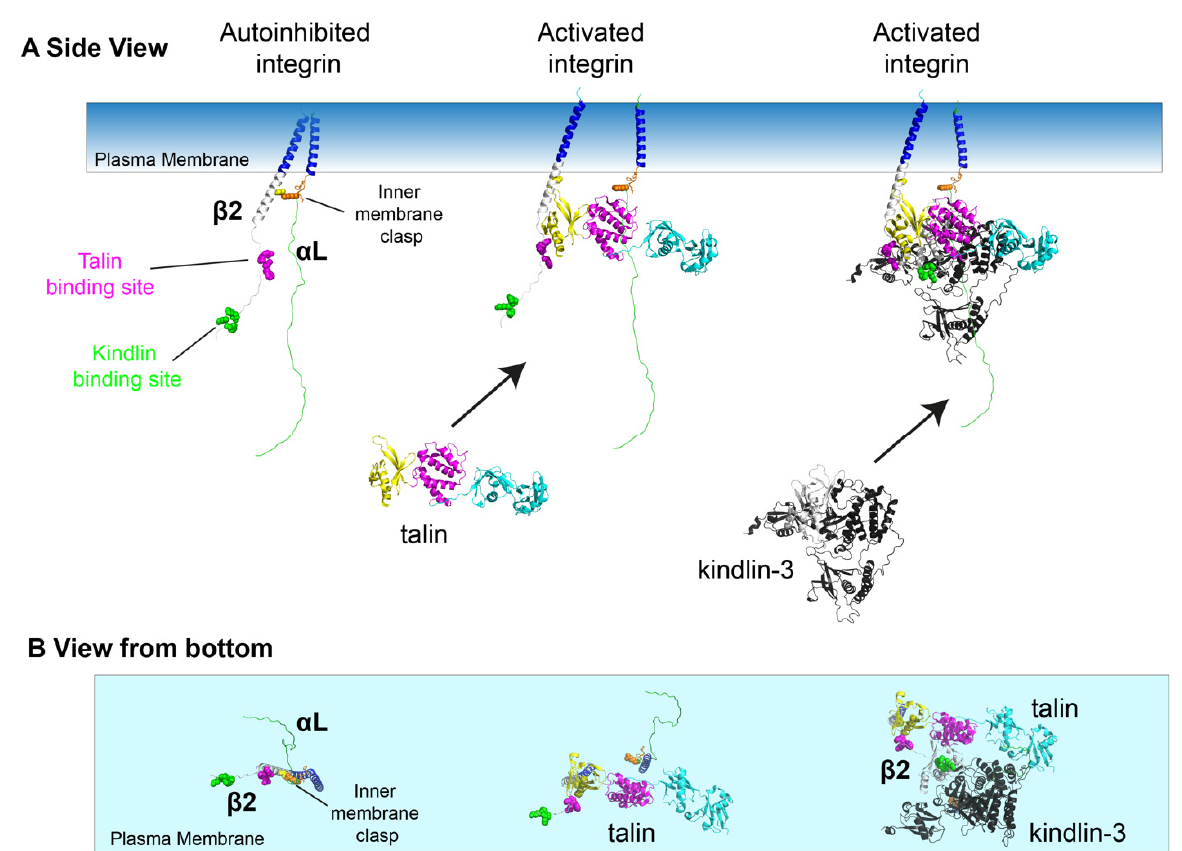
Figure 5. Talin and kindlin interactions to activate integrin. ( A ). Side view. Autoinhibited integrin is maintained by the inner membrane clasp (left panel, orange). Talin-binding site in magenta, kindlin binding site in green. Talin binding to the membrane proximal NPLF leads to breaking of the inner membrane clasp and α L β 2 leg separation (middle panel). Kindlin-3 (black) can bind the β 2 tail simultaneously or sequentially with talin-1. Only the open conformation of the talin head is shown here, as the F1 domain moving out of the way creates space for the kindlin-3 to dock in more easily to form an activated integrin-talin-kindlin complex. ( B ). Bottom view of cooperation of talin-1 and kindlin-3 in integrin activation corresponding to the side views shown in panel A.